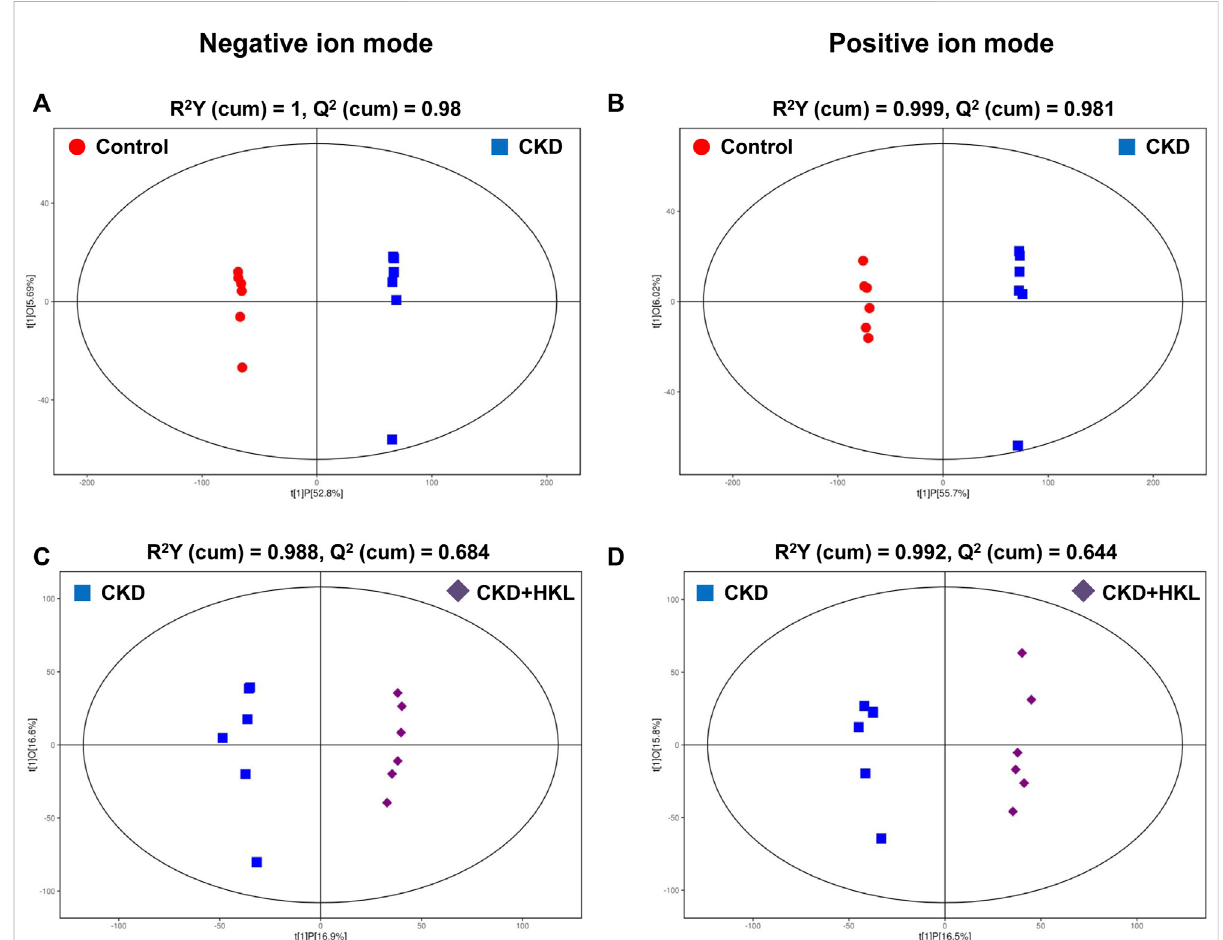
FIGURE 4 ScorescatterplotsofOPLS-DAmodel. (A) OPLS-DAscore plotofthecontrolandtheCKDgroupinnegativeionmode. (B) OPLS-DAscoreplot ofthecontrolandtheCKDgroupinpositiveionmode. (C) OPLS-DAscoreplotoftheCKDandtheCKD+HKLgroupinnegativeionmode. (D) OPLS- DA score plot of the CKD and the CKD + HKL group in positive ion mode. The red dots represent the control group, the blue squares represent the CKD group, and the purple diamonds represent the CKD + HKL